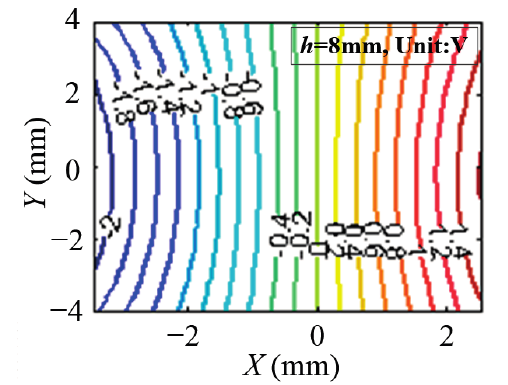
Figure 8. Equipotential line of the magnetic field represented by different colors.